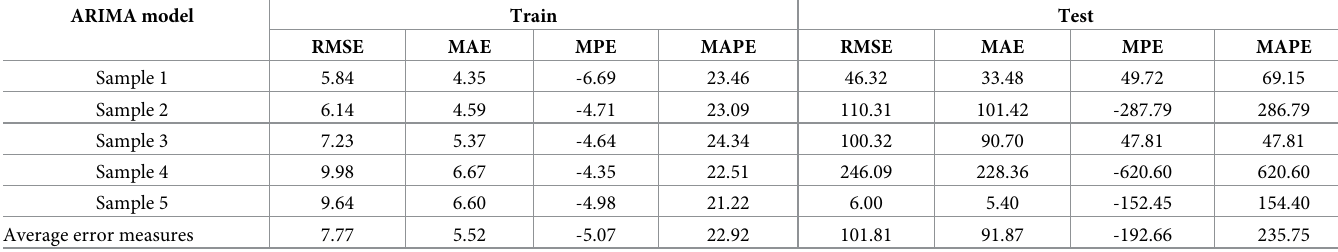
Table 4. Evaluation of parameters for the ARIMA models of different training and test sets for COVID-19 deaths. ARIMA model